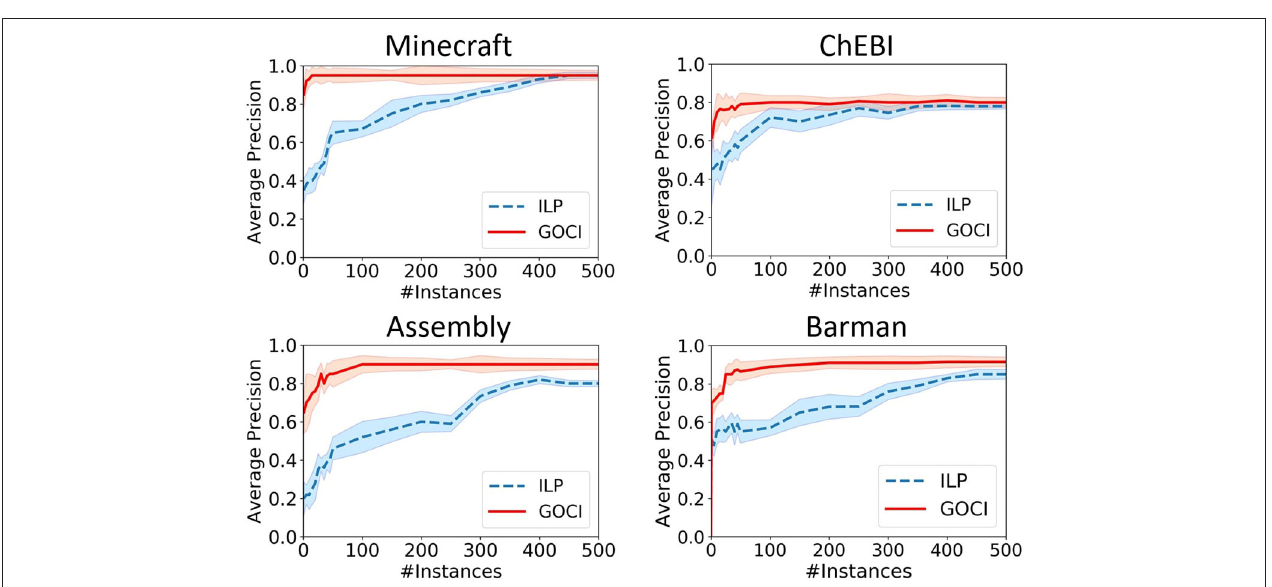
FIGURE 6 | Learning curves for varying sample size to compare the sample efficiency of Guided One-shot Concept Induction (G OCI ) and inductive logic program (ILP). Top two plots are with respect to structural composition domains-Minecraft & ChEBI and the bottom two are for planning domains: Assembly and Barman (best viewed in